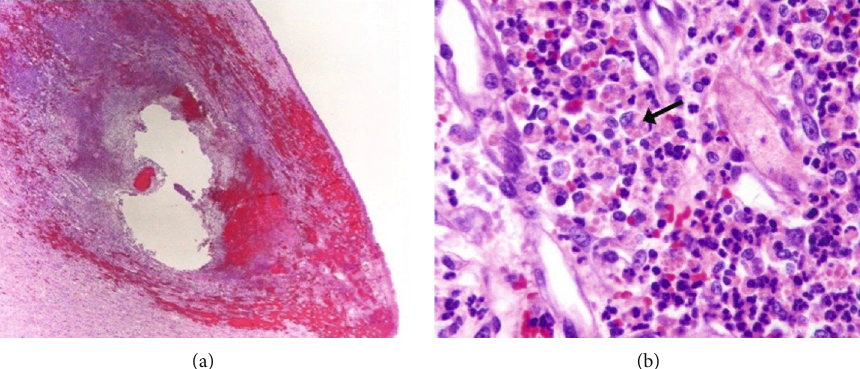
Figure 4: Histopathology micrograph, Kidney H&E. (a) Within the grossly red renal foci, the renal medulla was multifocally e ff aced by suppurative foci. (b) Higher magni fi cation view of the in fi ltrating neutrophils and macrophages, the latter of which often contained granular to globular, eosinophilic, intracytoplasmic phagocytic debris (arrow). No pathogen were